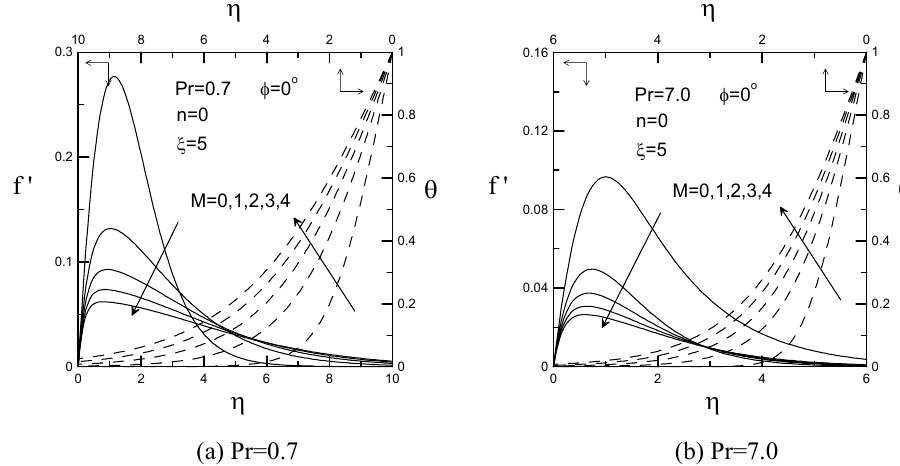
Figure 3 The effect of M on the velocity and temperature profiles for (a)Pr=0.7 and (b)Pr=7.0 with n=0 and φ =0° at ξ